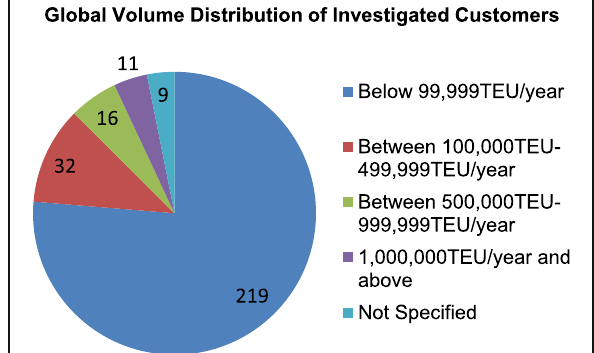
Fig. 2 Global volume distribution of investigated